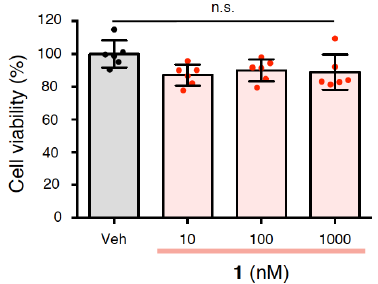
Figure 5. Neurotoxicity of rat primary cerebral cortex cells treated with 1 at the indicated concentrations for 24 h. The data are presented as mean ± SD ( n = 6). n.s.: not significant. Veh: vehicle. Red or black dots represent each value.